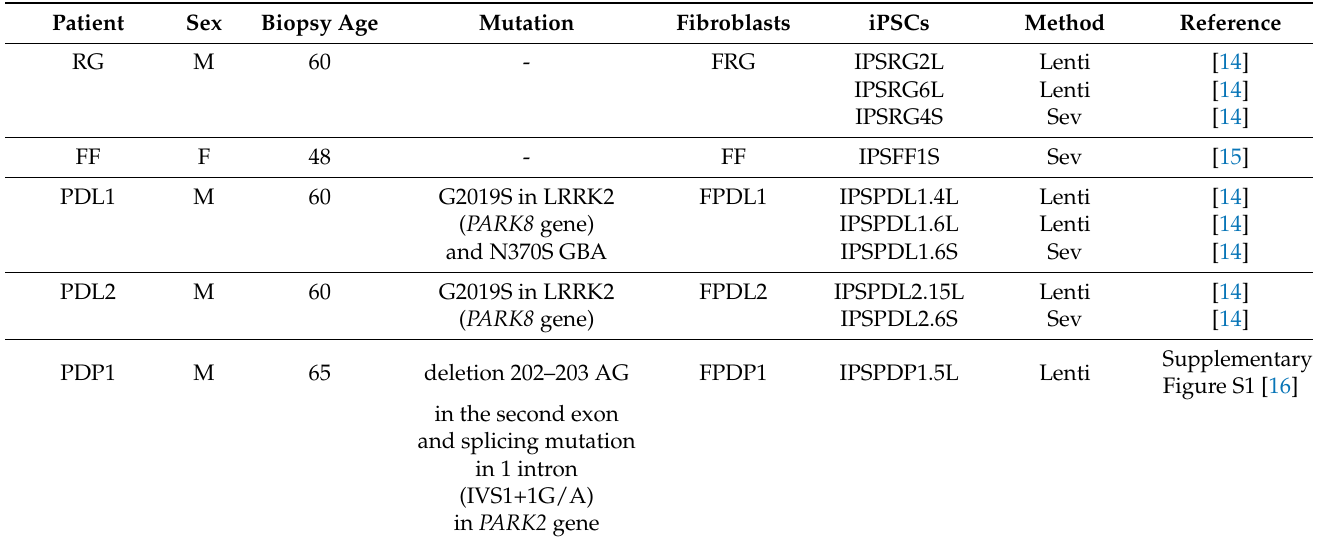
Table 1. IPSC lines